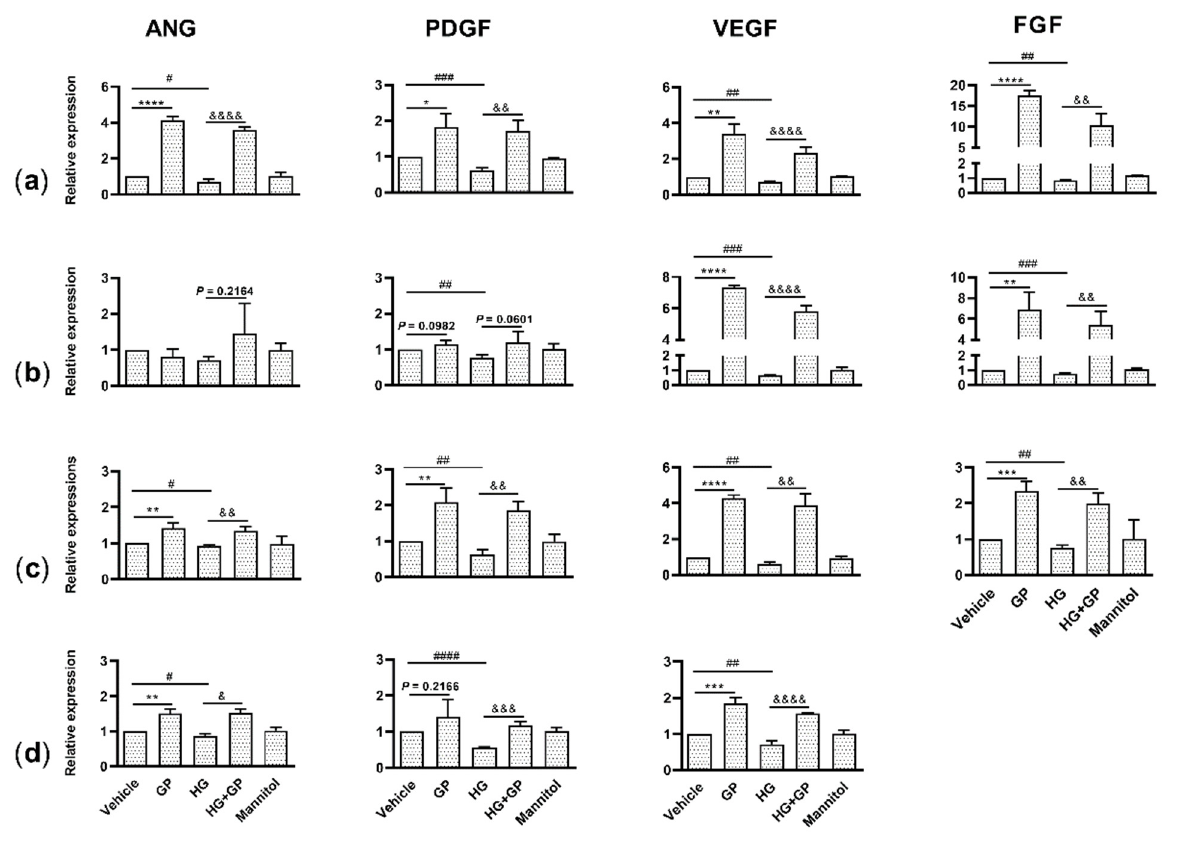
Figure 4. G. procumbens increases the expression of genes involved in wound healing in human keratinocytes, fibroblasts, endothelial cells and mast cells cultured in diabetic conditions: ( a ) Primary human keratinocytes, ( b ) fibroblasts, ( c ) endothelial cells and ( d ) the human mast cell line LAD2 were pretreated with 38 mM glucose (high glucose) or 38 mM mannitol for 24 h and then stimulated with 100 µ g/mL G. procumbens (GP) or 0.1% DMSO in normal medium (Veh: vehicle) or 0.1% DMSO in high-glucose medium (HG) for 48 h. mRNA expression of ANG, PDGF, VEGF and FGF was measured with real-time PCR. The values are presented as the mean ± SD of five independent experiments. * p < 0.05, ** p < 0.01, *** p < 0.001 and **** p < 0.0001 for the comparisons between vehicle and G. procumbens (GP) in normal medium. & p < 0.05, && p < 0.01, &&& p < 0.001 and &&&& p < 0.0001 for the comparisons between vehicle (HG) and G. procumbens (HG+GP) in high-glucose medium. # p < 0.05, ## p < 0.01, ### p < 0.001 and #### p < 0.0001 for the comparisons between vehicle in normal medium and vehicle in high-glucose medium (HG).